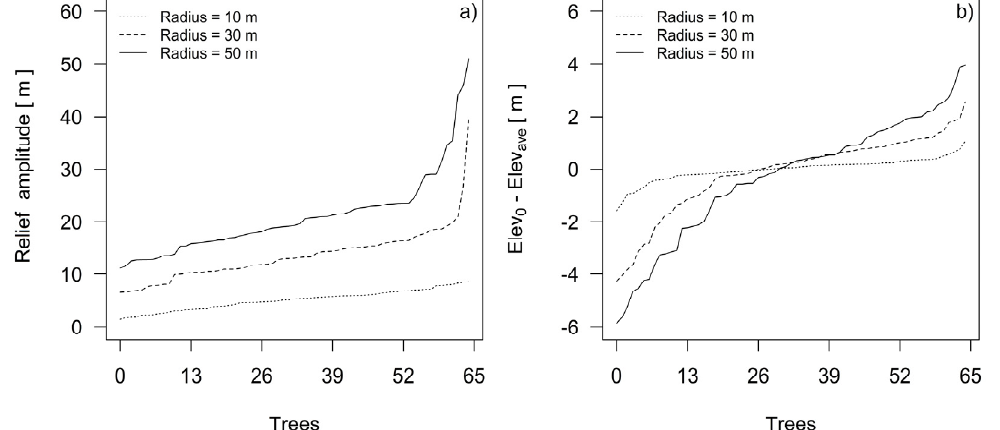
4 Figure 4. Relief amplitudes ( a ) and differences between elevations at the base point position of the silver firs and the average elevation differences on their growth sites ( b ). Note that for different radii, trees are ordered according to amplitudes ( a ) or differences between the elevation at the base point of silver fir and the average elevation on its growth sites ( b